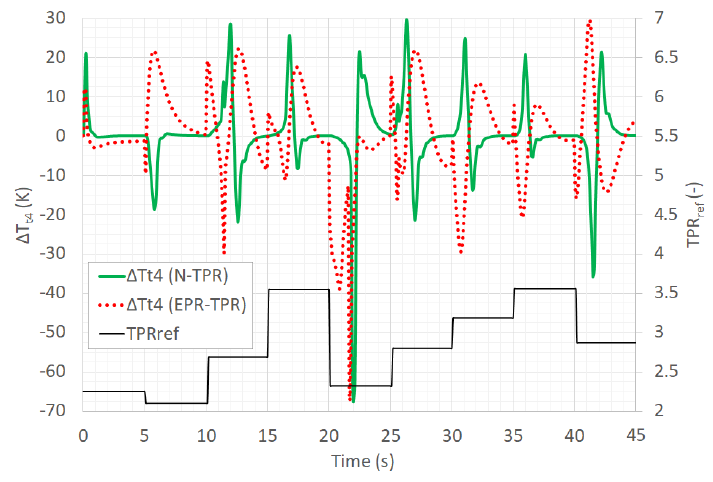
Figure 9. Shift in turbine inlet temperature due to rotor speed and EPR control laws in contrast to TPR control as